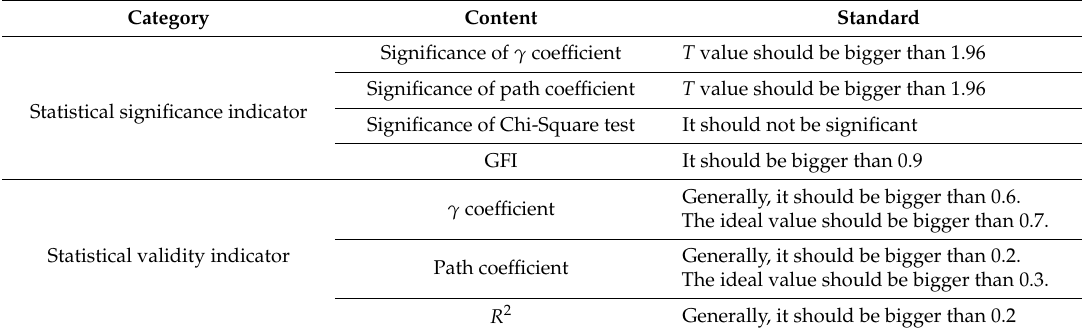
Table 5. Criteria for formative